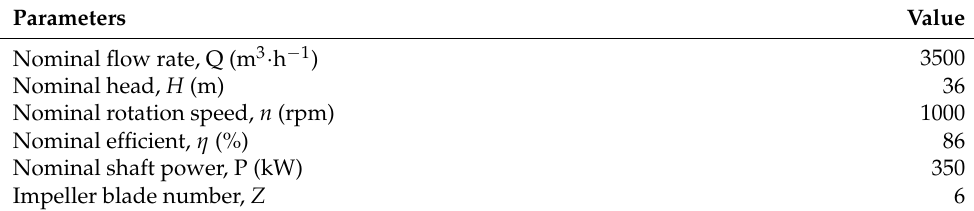
Table 1. Main parameters of double-suction centrifugal